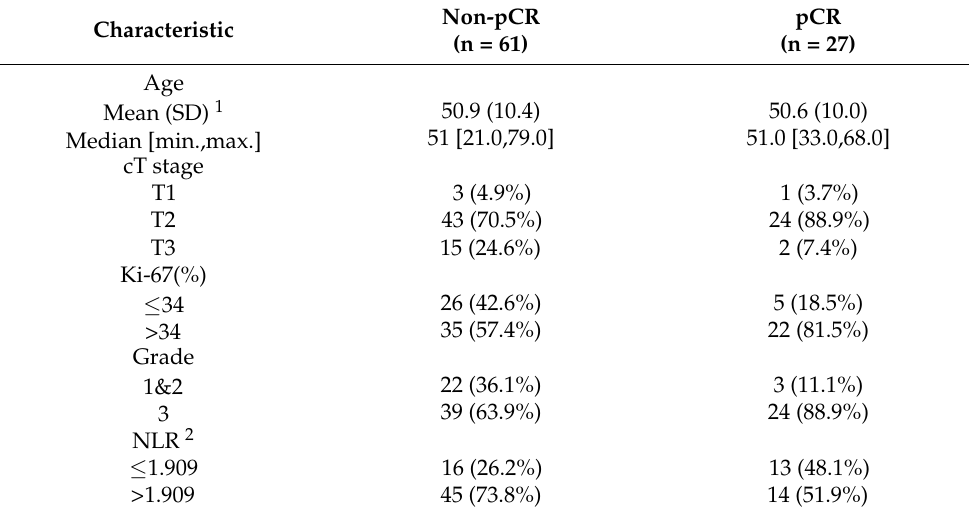
Table 1. Demographic data of